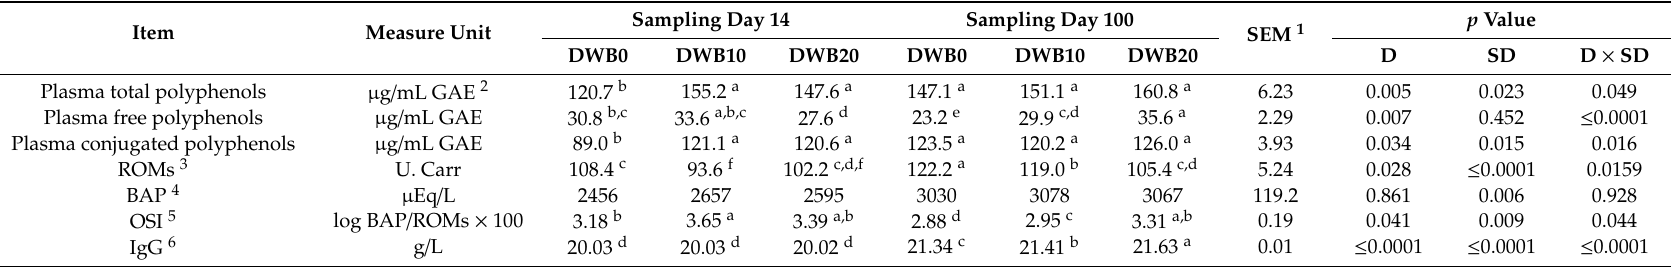
Table 4. E ff ect of diet (D) and sampling day (SD) on plasma polyphenols, oxidative status and immune parameter of